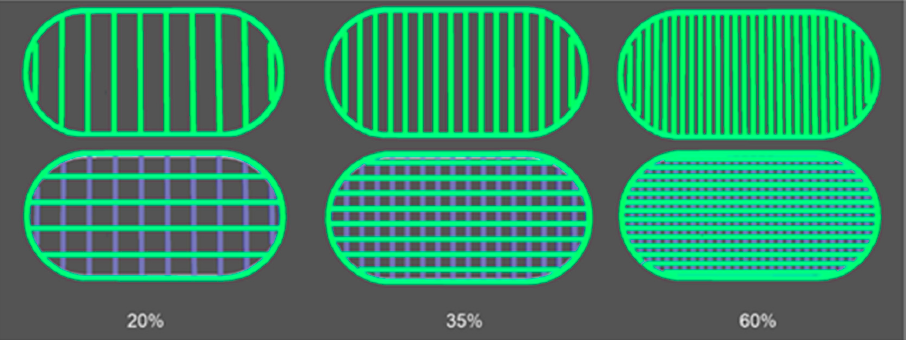
Table 5. Comparison of μ CT scan data of 3DP PVA_K/CL tablets with 20% (T_20), 35% (T_35), and 60% (T_60) infill ratio.